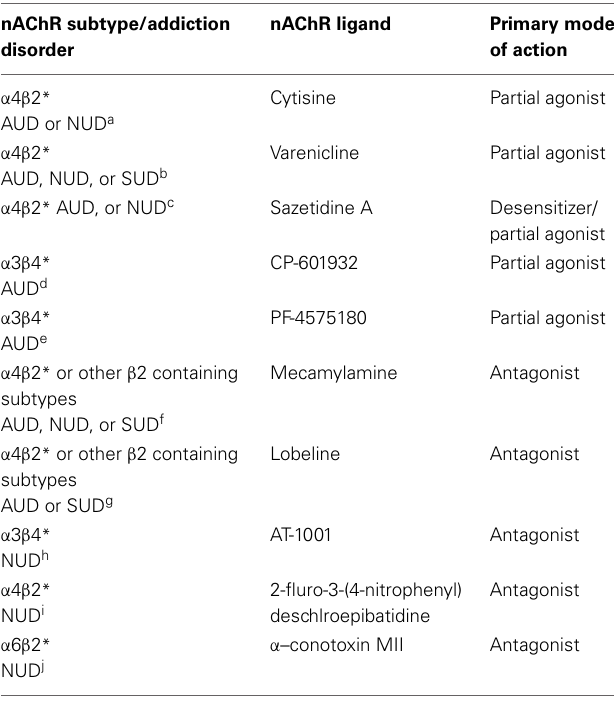
Table 2 | Brain nAChR subtypes and pharmacological agents involved in alcohol/nicotine or substance use